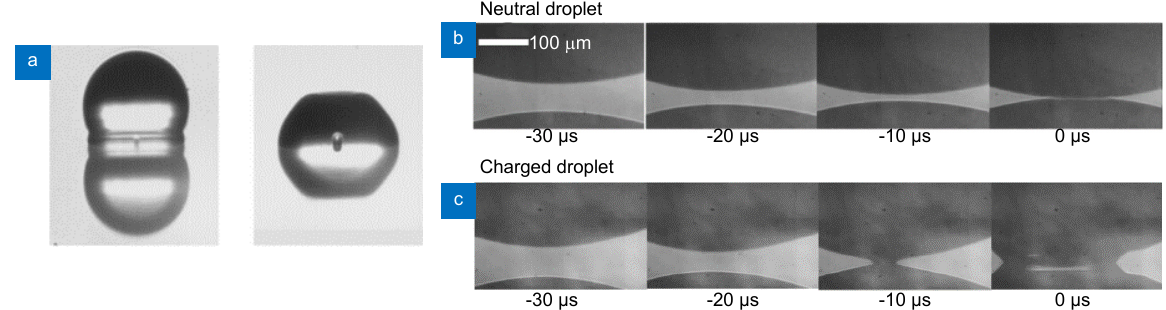
Fig. 3 | The impact of a single droplet on the solid and smooth substrate for the inkjet printing 17 . ( a ) Side-view of impact process of neu- tral and charged droplets on mirror-like ITO glass. (b) Neutral droplet and (c) droplet charged at 63 pC. Impacting velocity for both senarios: 0.6 m/s, droplet radius: 1.25 mm 48